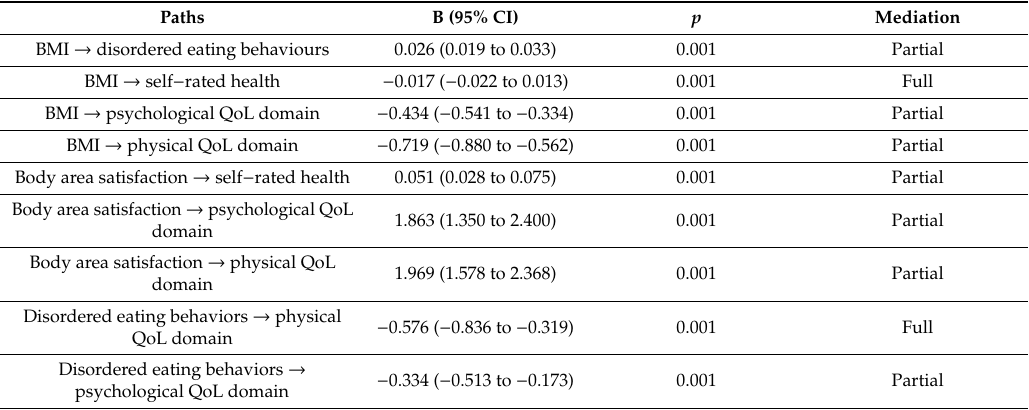
Table 5. Summary of the mediation analyses that tested the indirect e ff ect of body image and disordered eating behaviors on psychological and physical quality of life aspects ( n =